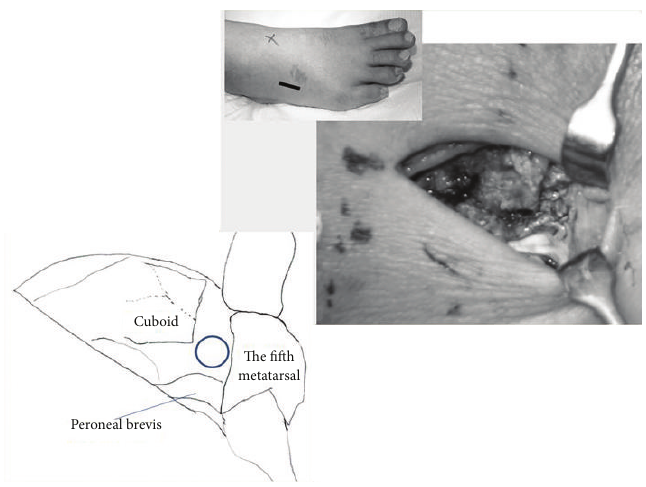
Figure 3: Intraoperative findings. I : insert position of arthroscopy.